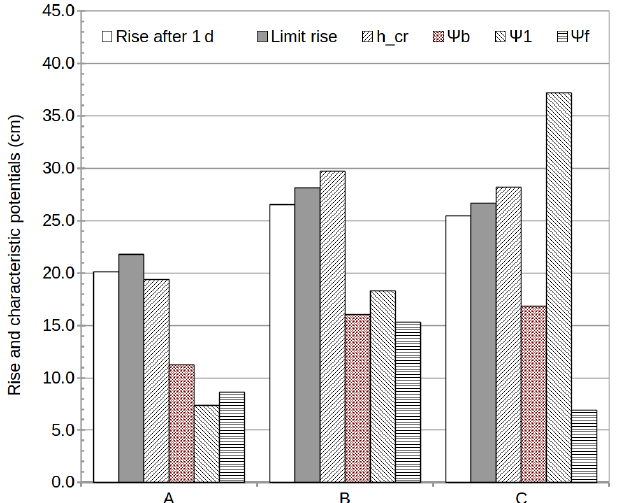
Figure 10. Comparison between the measured height of capillary rise after 1d, the limit height of capillary rise, the height of capillary rise h cr estimated by means of the Polubarinova-Kochina formula, and the absolute values of the characteristic potentials (cid:57) b , (cid:57) 1 and (cid:57) f for the three soils used to repeat Perrault’s